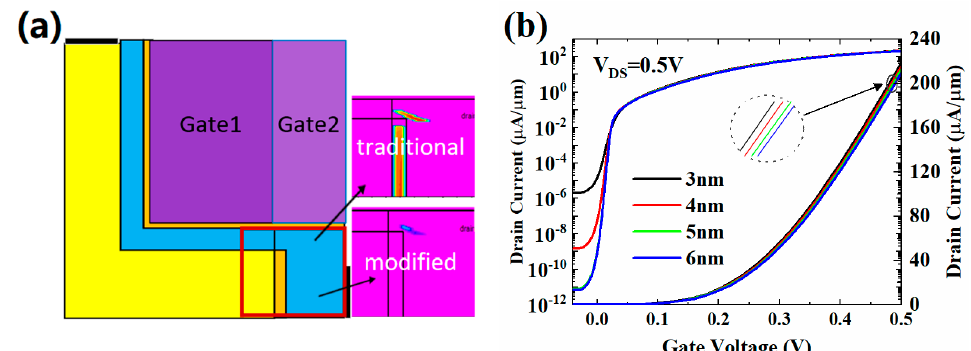
Figure 9. ( a ) OFF-state tunneling rate distribution with traditional low-doped spacer layer or modified HFO2barrier layer and ( b ) transfer characteristic curves with different thickness of HfO2 barrier layer.